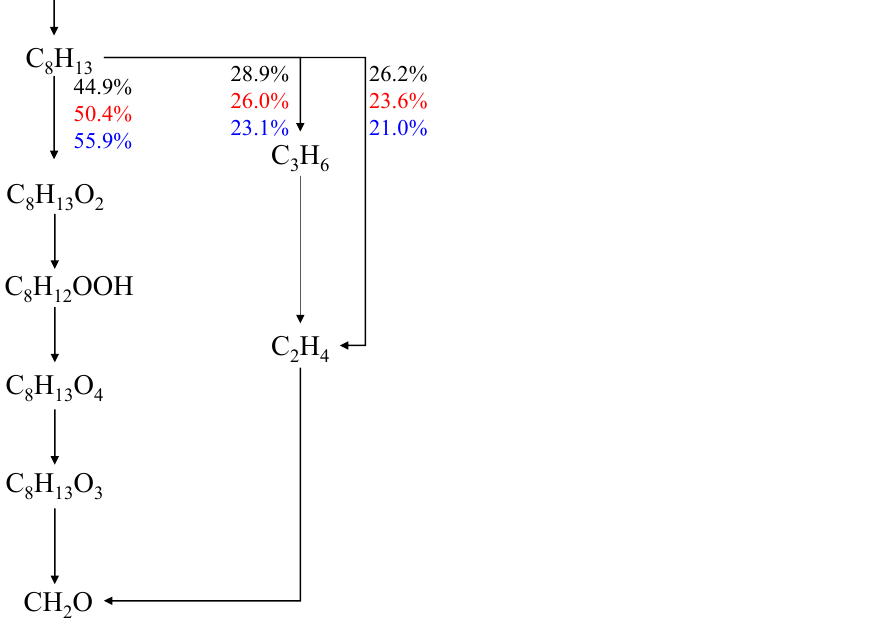
Figure 12. Effects of initial pressure on the chemical reaction path of gasoline (T = 800 K; Φ = 1; black: P = 15 bar; red: P = 20 bar; blue: P = 25 bar) .